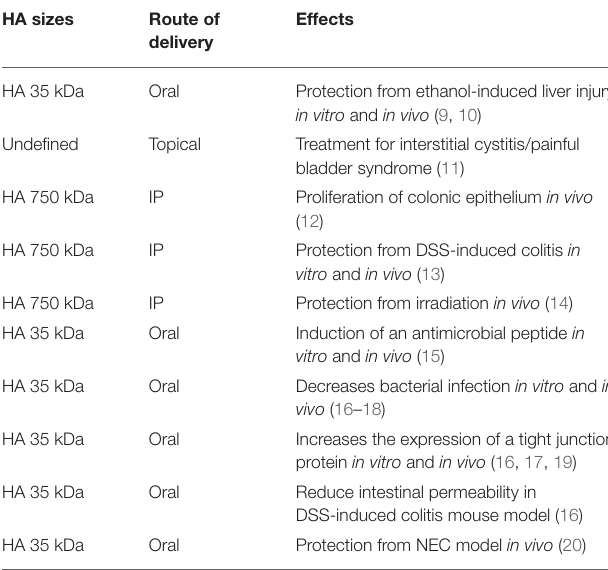
TABLE 1 | Summary of HA used in pre-clinical